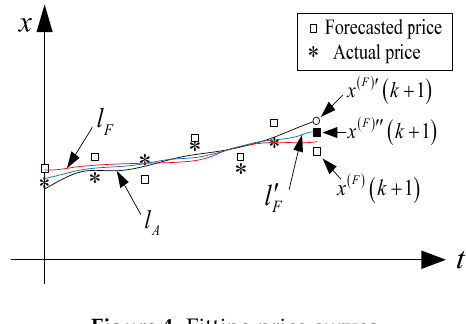
Figure 4. Fitting price curves.